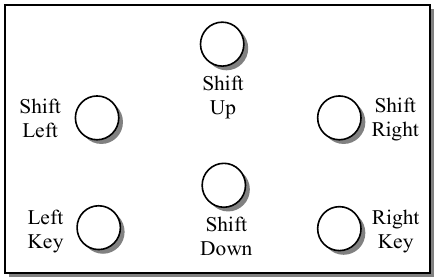
ff erent Figure 9. Function configuration of different microphones. Figure 9. Function configuration of di Figure 9. Function configuration of different microphones. Figure 9. Function configuration of different microphones.